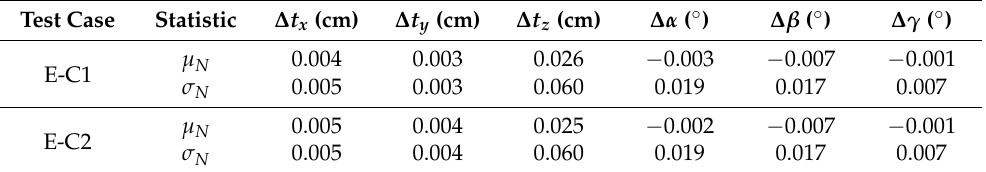
Table 19. Mean and standard deviation of the pose estimation errors for different levels of uncertainty in the knowledge of the camera intrinsic parameters, for test cases E-C1 and E-C2.